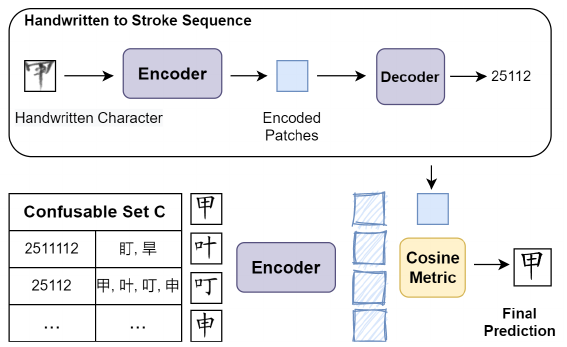
Figure 7. The architecture of the stroke-based zero-shot recognition